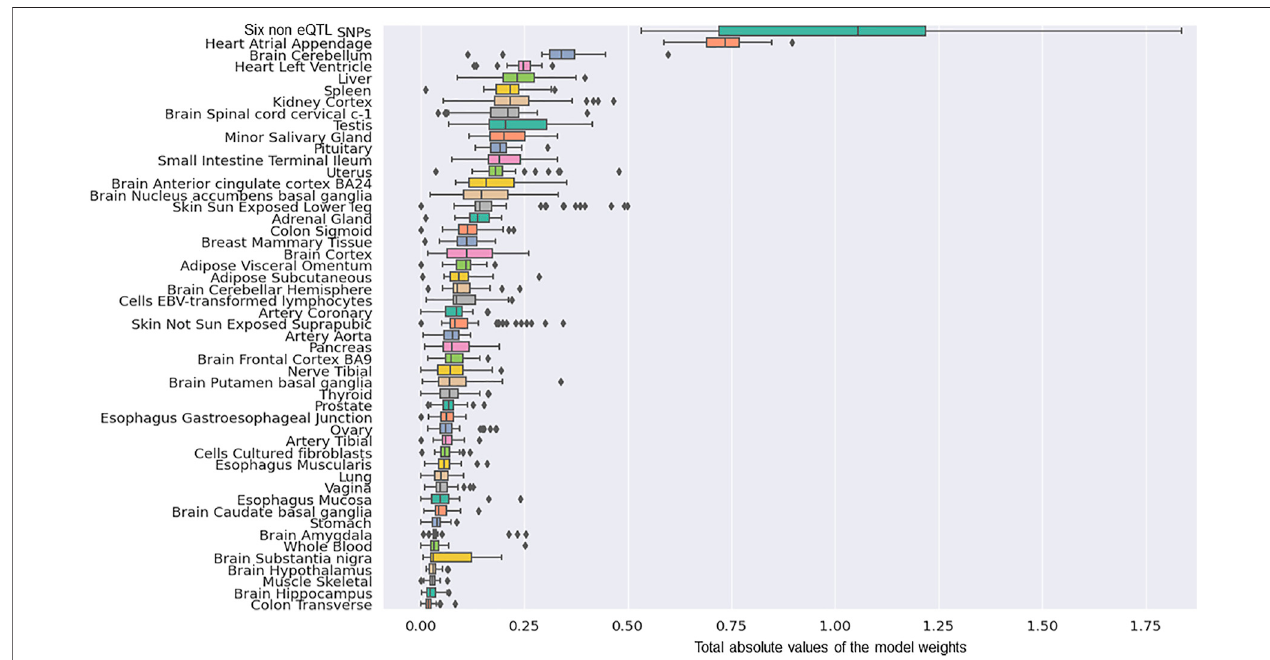
FIGURE 3 | The rank order of tissue-speci fi c risk contributions calculated across 50 predictor models created from randomised modelling and model-1 ’ s hyperparameters. The tissue ranking was consistent with that observed for model-1.